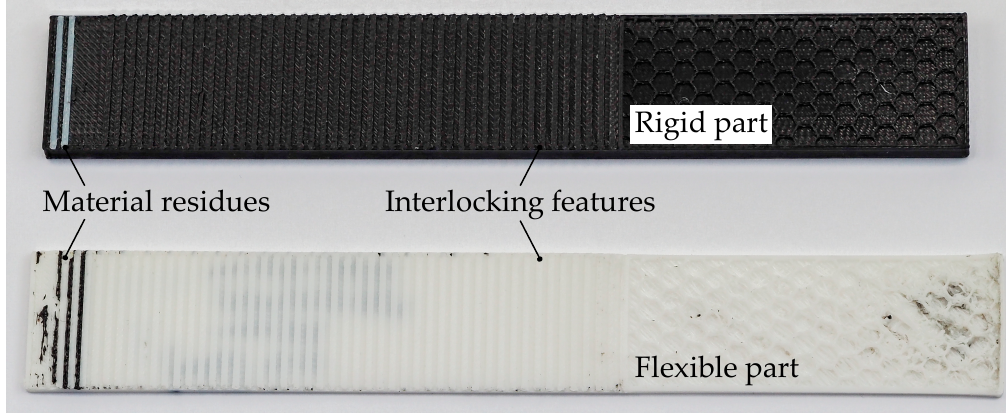
Figure 11. PLA/NinjaFlex specimen with interlocking features after roll peeling tests. Figure 11. PLA / NinjaFlex specimen with interlocking features after roll peeling